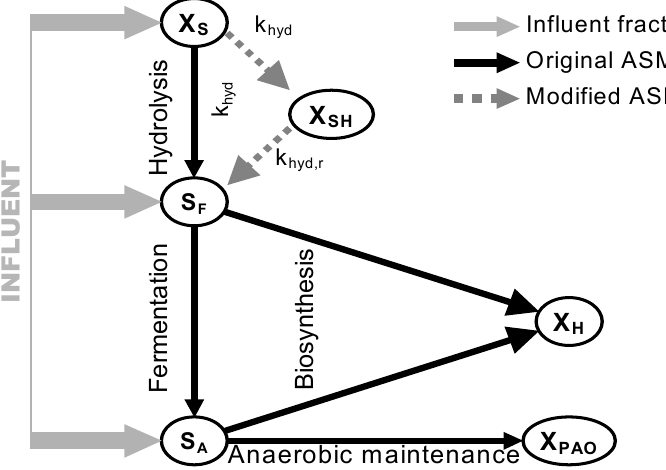
Figure 1. Hydrolysis concept in the original Activated Sludge Model no. 2d (ASM2d) and its modification [20].